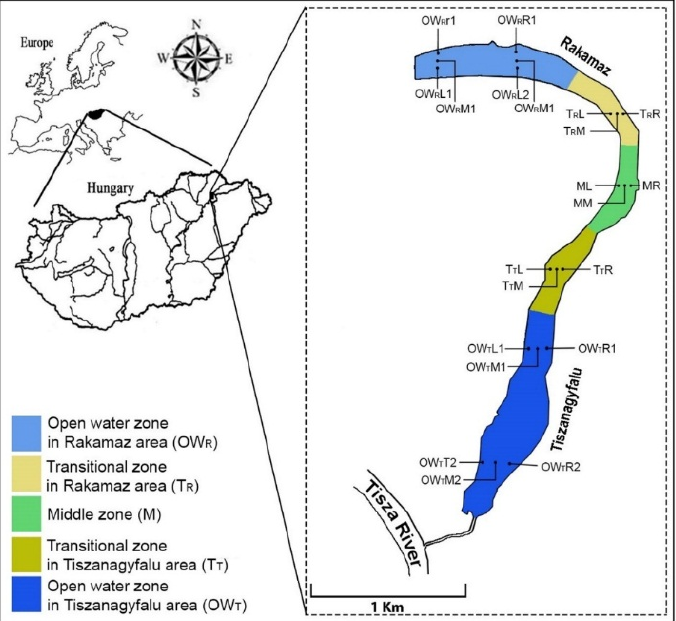
Figure 1. Location of the Nagy–Morotva oxbow lake with indications of the sampling points. OW R represents the Open water zone of the Rakamaz area with the sampling transects and the sampling points. T R indicates the transitional zone between the open water zone of Rakamaz area (OW R ) and the middle zone (M) which is characterized by a large macrovegetation coverage. T T indicates the transitional zone between the open water zone of the Tiszanagyfalu area (OW T ) and the middle zone (M). OW T indicates the Open water zone of Tiszanagyfalu area. The numbers 1 and 2 represent the transects inside the zones. The L represents the left part of transects, the M represents the middle part of transect, and the R represents the right part of transects; these abbreviations apply to all sampling